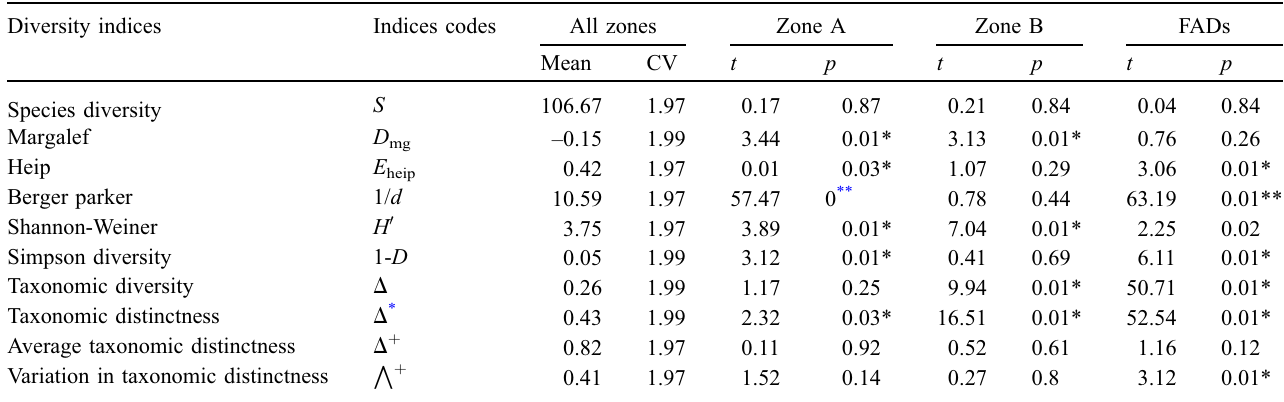
Table 3. Mean value and coef fi cient of variation (CV) of the diversity indices. Welch's t -test values shown for species diversity indices between the two sampling zones A and B in coastal Kenya. Indices descriptors are shown in Table 1. Signi fi cant values ( p < 0.05) are marked by an